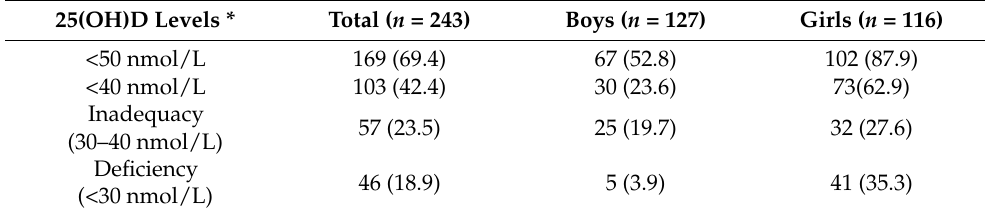
Table 2. Proportion of participants at various serum 25(OH)D cut-offs to define deficiency ( N =